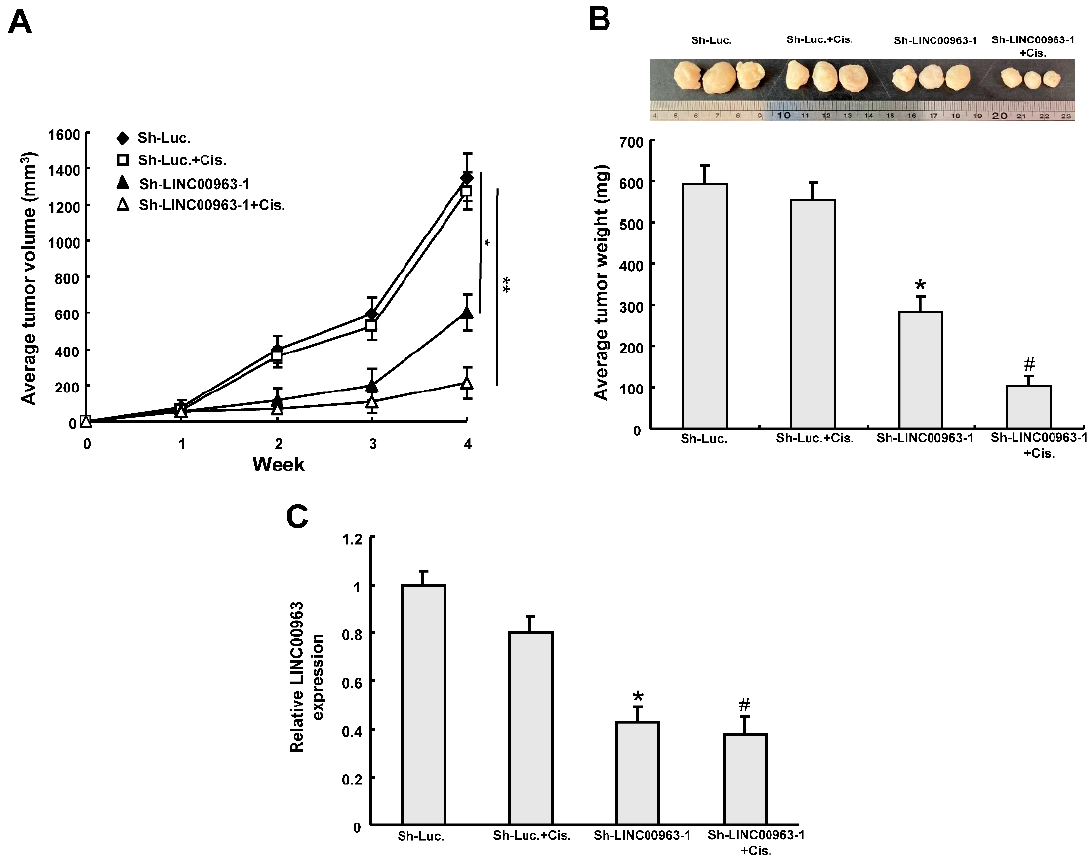
Figure 6. LINC00963 knockdown enhances chemosensitivity in mice. Tumor volume ( A ) and the tumor weight ( B ) was measured after injection of SAS-CSC treated with indicted treatment. ( C ) The relative expression of LINC00963 expression of in the excised tumors. * p < 0.05 sh-LINC00963 group compared to the sh-Luc group. # p < 0.05 sh-LINC00963 + Cis. group compared to sh-Luc. + Cis. group. Define.